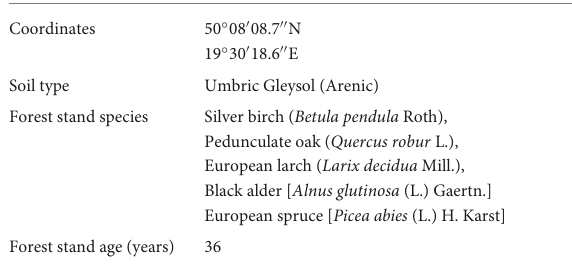
TABLE 1 Description of study site.